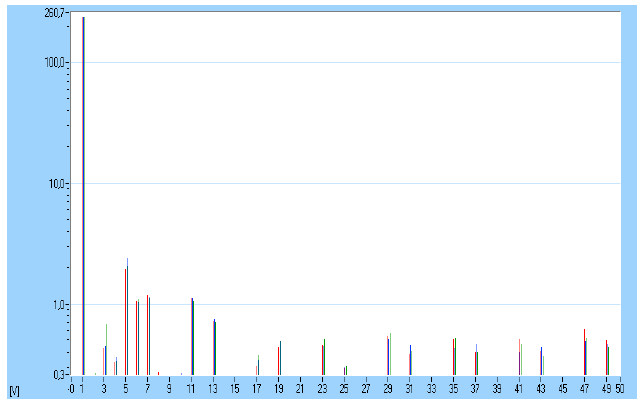
Fig. 9. Spectrum of harmonic voltage of higher levels with designated permitted limits in accordance with CSN EN 50160 – BPS2